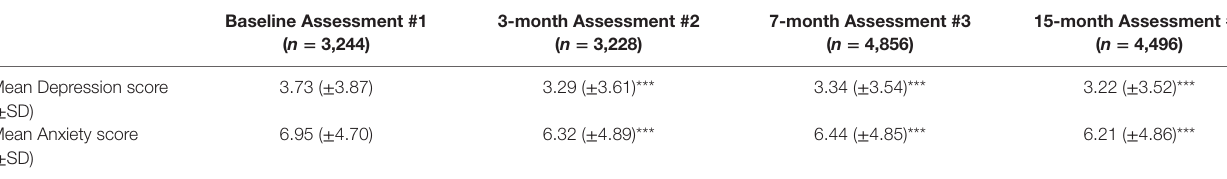
TaBle 4 | changes in Depression and anxiety scores for entire study population.